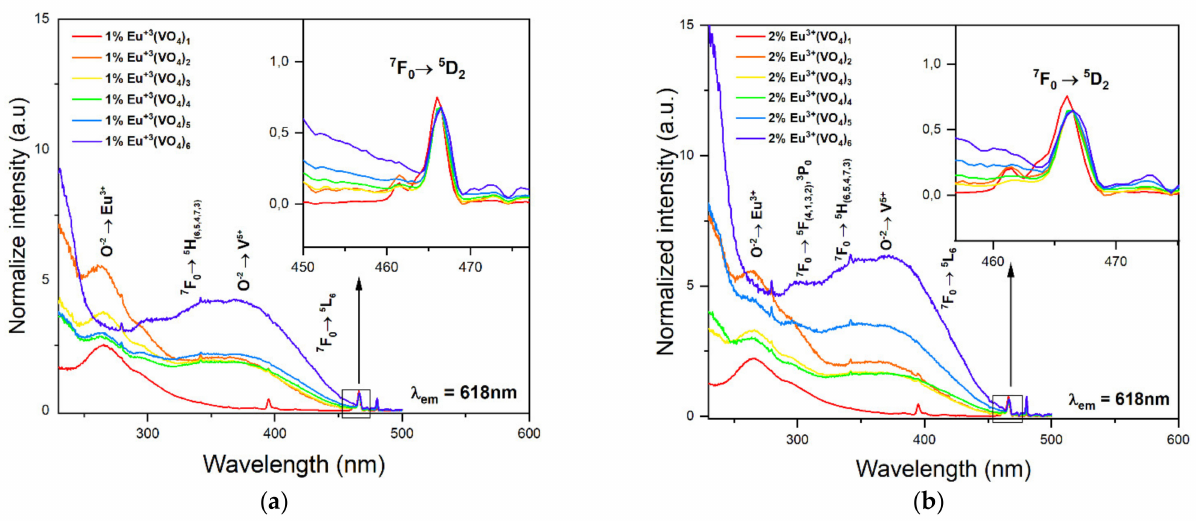
Figure 6. Emission spectra of ( a ) Ca 9.9 Eu 0.1 (PO 4 ) 6 − x (VO 4 ) x (OH) 2 and ( b ) Ca 9.8 Eu 0.2 (PO 4 ) 6 − x (VO 4 ) x (OH) 2 , where x is equal 1, 2, 3, 4, 5, and 6.The excitation wavelength was equal to 396 nm and a 525 nm filter was used in this